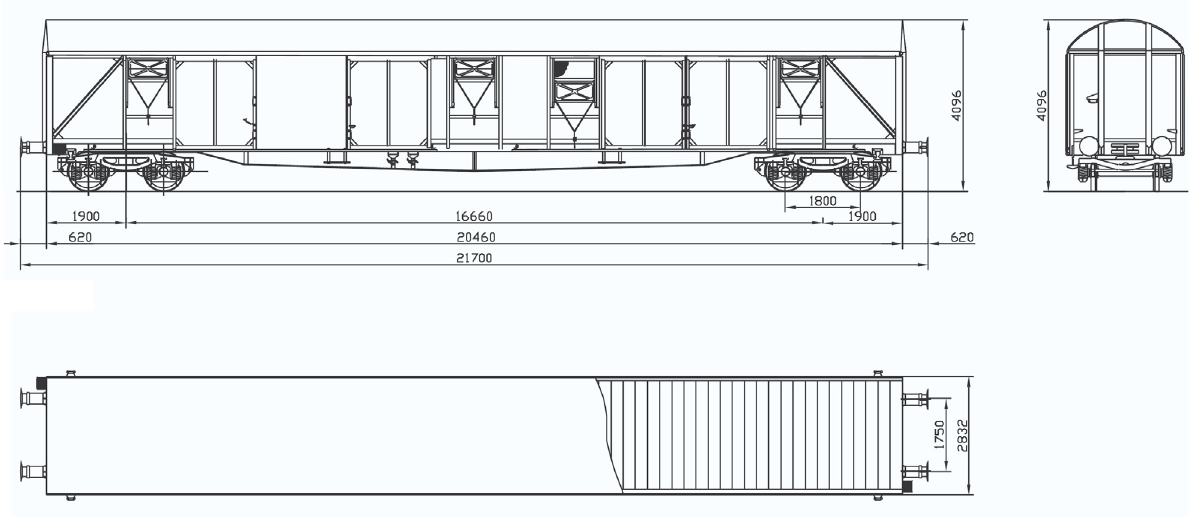
Figure 1: Dimension of a standard freight “GABS” car.